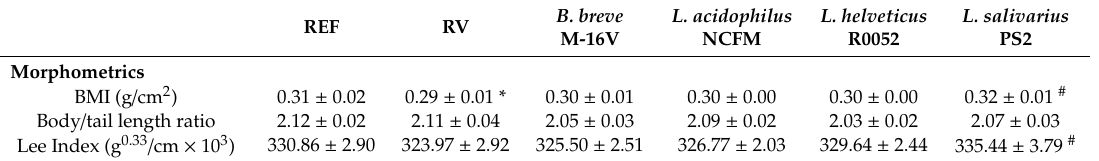
group. # p < 0.05 compared to the rotavirus (RV) group. BMI: body mass index; B .: Bifidobacterium ; L .: Lactobacillus .